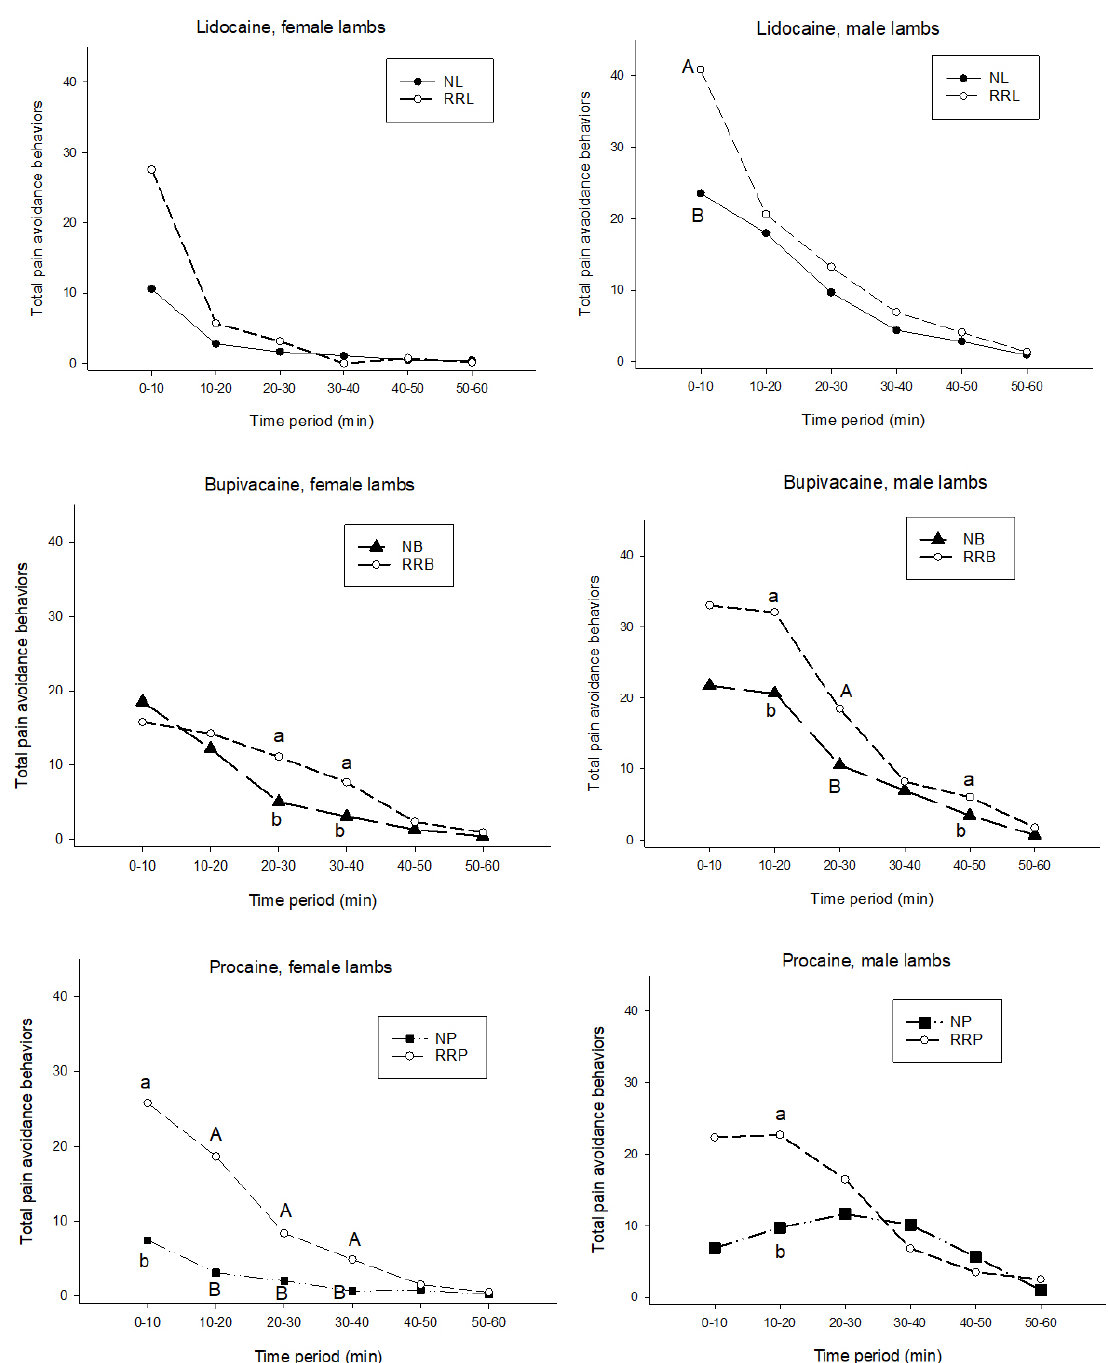
Figure 1. Total acute pain avoidance behaviors in ten-min blocks post ring castration and/or tail docking in female ( left ) and male ( right ) lambs receiving lidocaine ( top ); bupivacaine ( middle ) or procaine ( bottom ) as compared with lambs receiving no local anesthetic. Within each experiment, means within a time period with differing uppercase superscripts (A, B) differ significantly ( p < 0.05), while differing lowercase superscripts (a, b) indicate a tendency to differ (0.1 > p > 0.05). Error bars not shown to optimize visual clarity of charts (see Tables 3 and 4 for standard deviations). RRL ring only, no local anesthetic; NL ring applied with lidocaine administered using the Numnuts ® tool; RRB ring only, no local anesthetic; NB ring applied with bupivacaine administered using the Numnuts ® tool; RRP ring only, no local anesthetic; NP ring applied with procaine administered using the Numnuts ® tool.